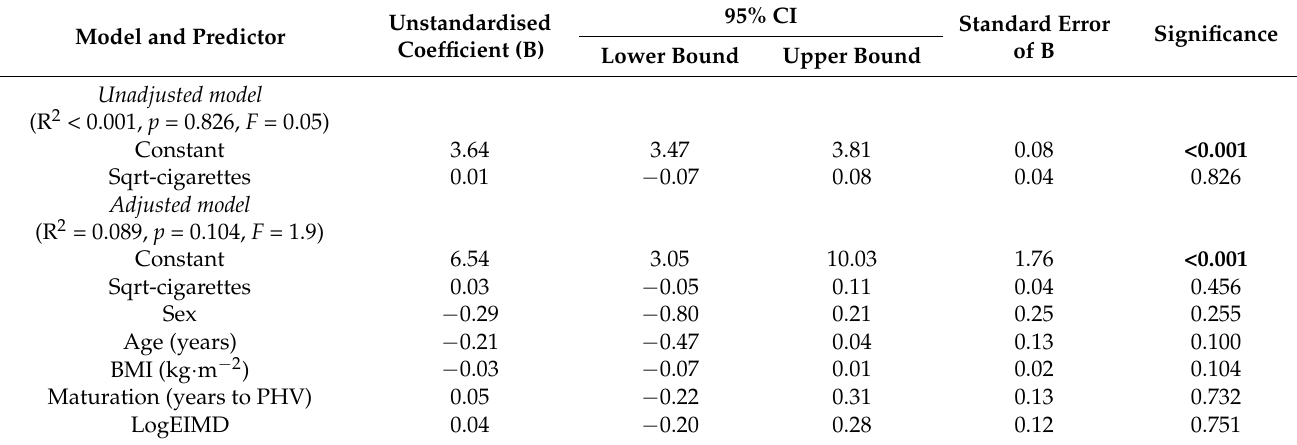
Table 4. Linear regression models examining association between smoking exposure and self-reported physical activity. Model and Predictor